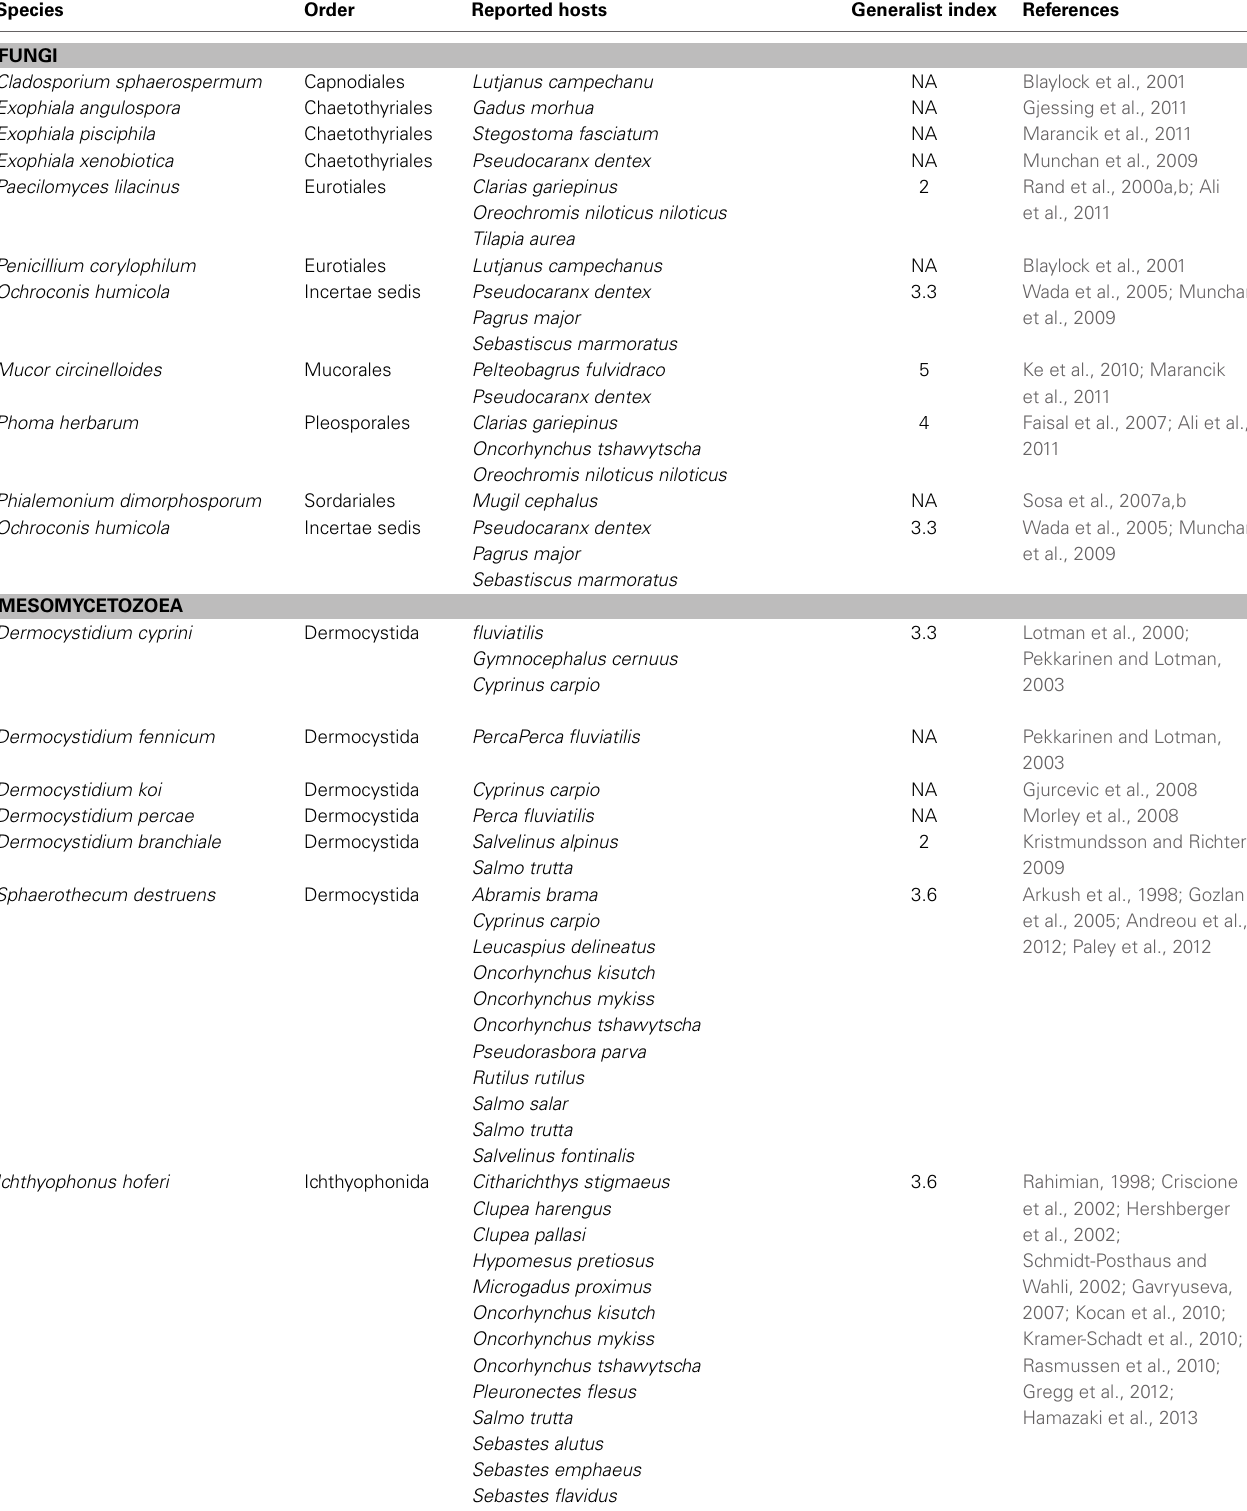
Table 1 | List of Fungi, Mesomycetozoea and Oomycetes species, which have been recorded as fish parasites in the Web of Knowledge since